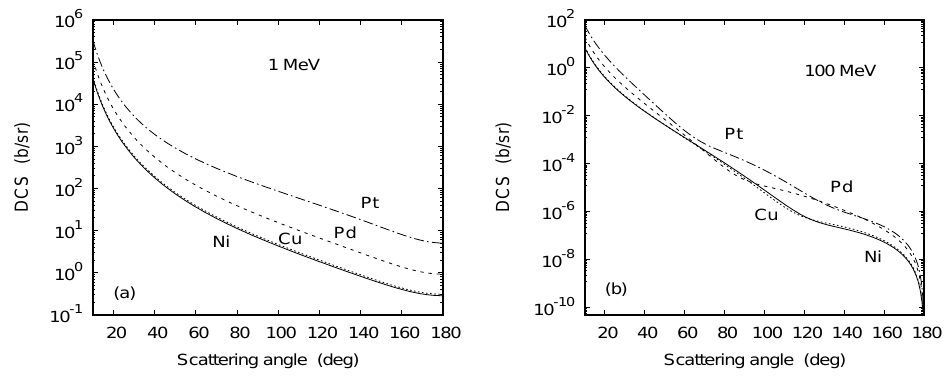
Figure 9. Angular dependence of the differential cross-sections for electron scattering from Ni 58 (——), Cu 63 ( · · · · · · ), Pd 108 ( − − −− ) , and Pt 196 ( − · − · − ) at impact energies of ( a ) 1 MeV and ( b ) 100